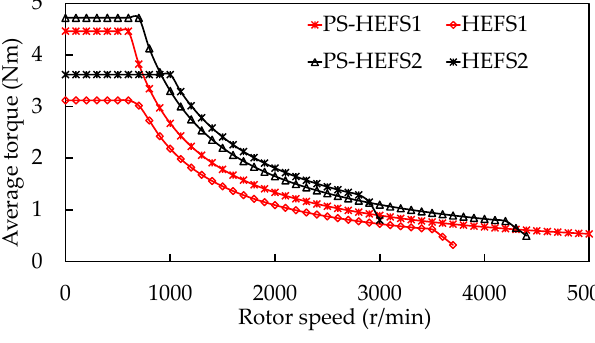
Figure 17. Predicted T-n curve.